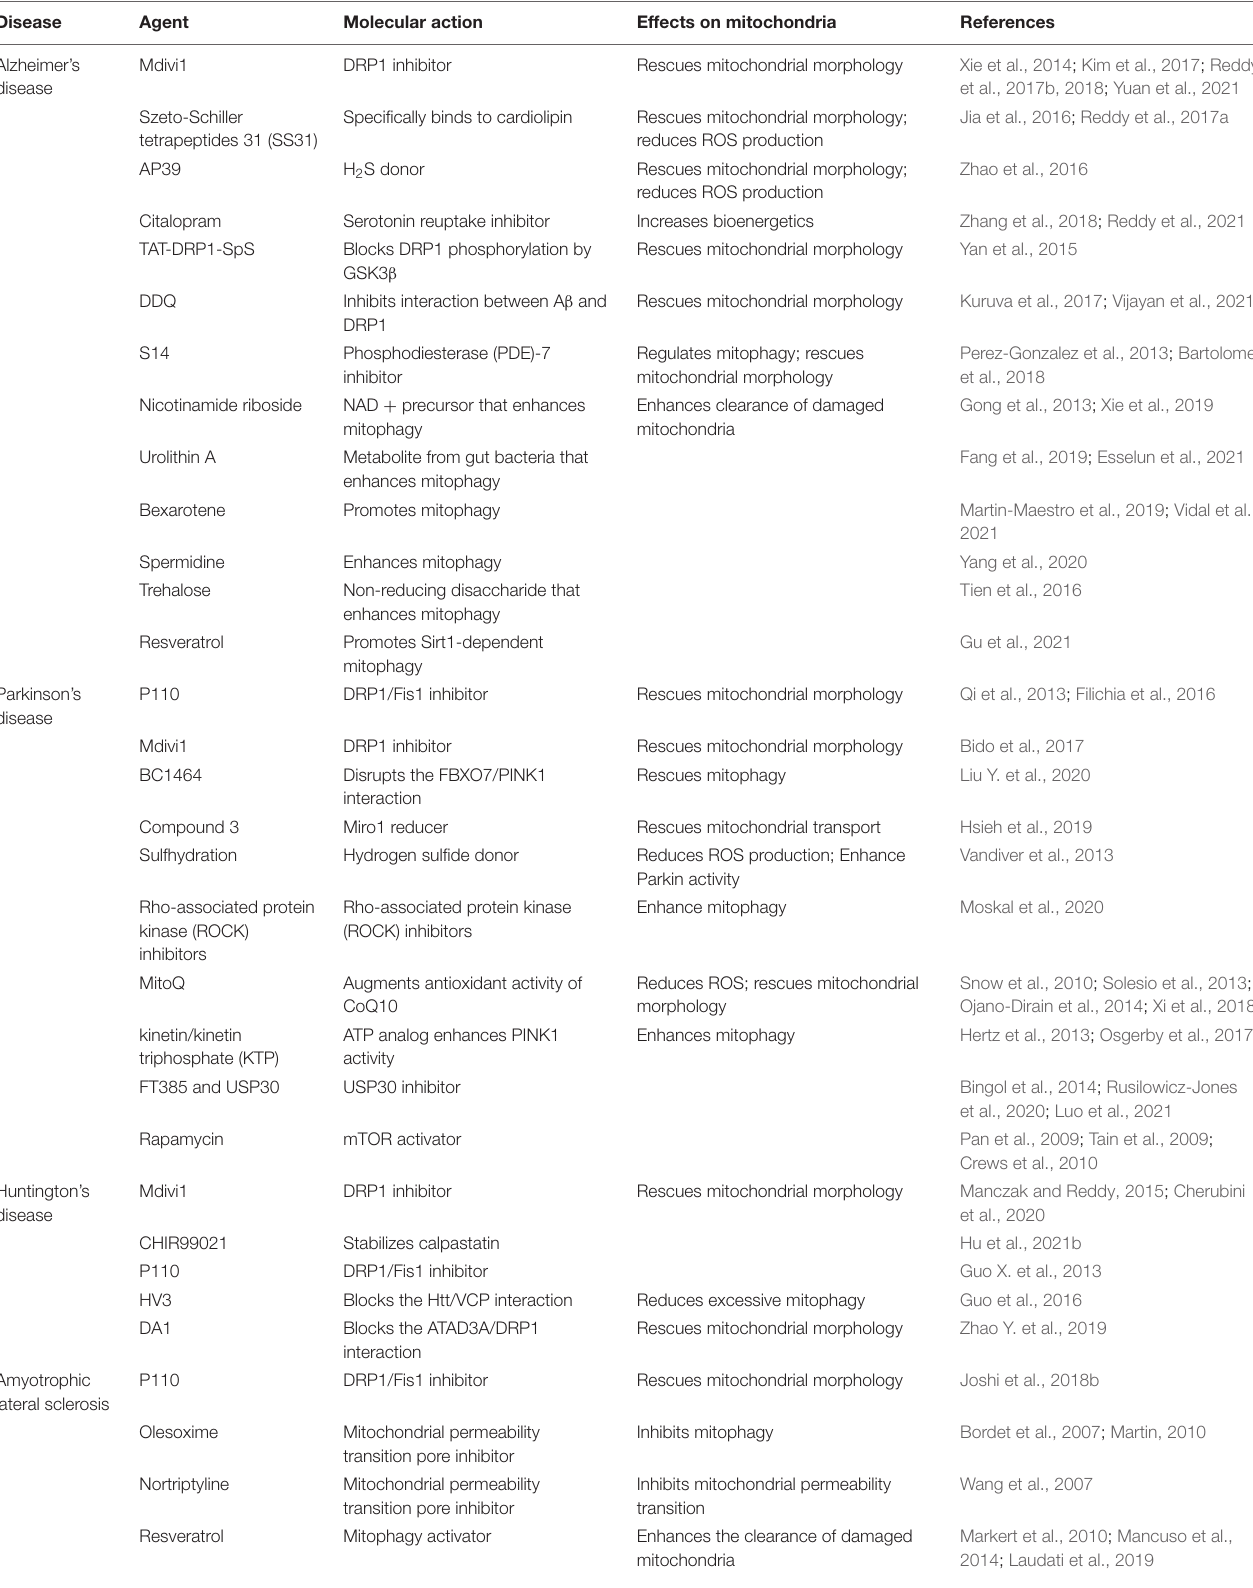
TABLE 2 | Function of therapeutic agents in neurodegenerative